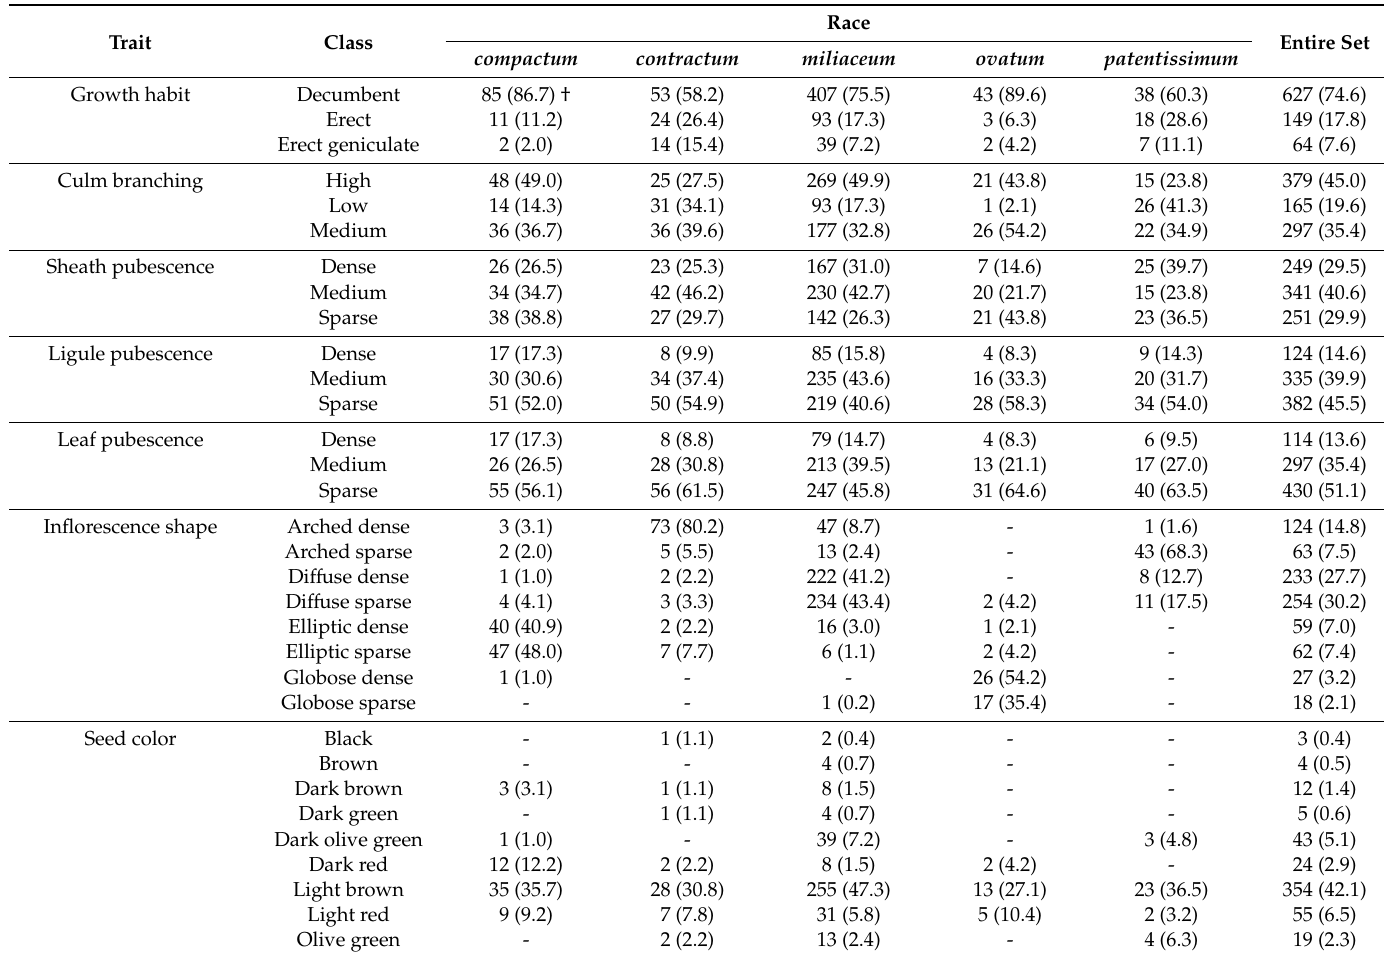
Table 2. Frequency of phenotypic classes of each qualitative trait in the five races and in the entire set of proso millet germplasm conserved at the ICRISAT genebank, Patancheru,